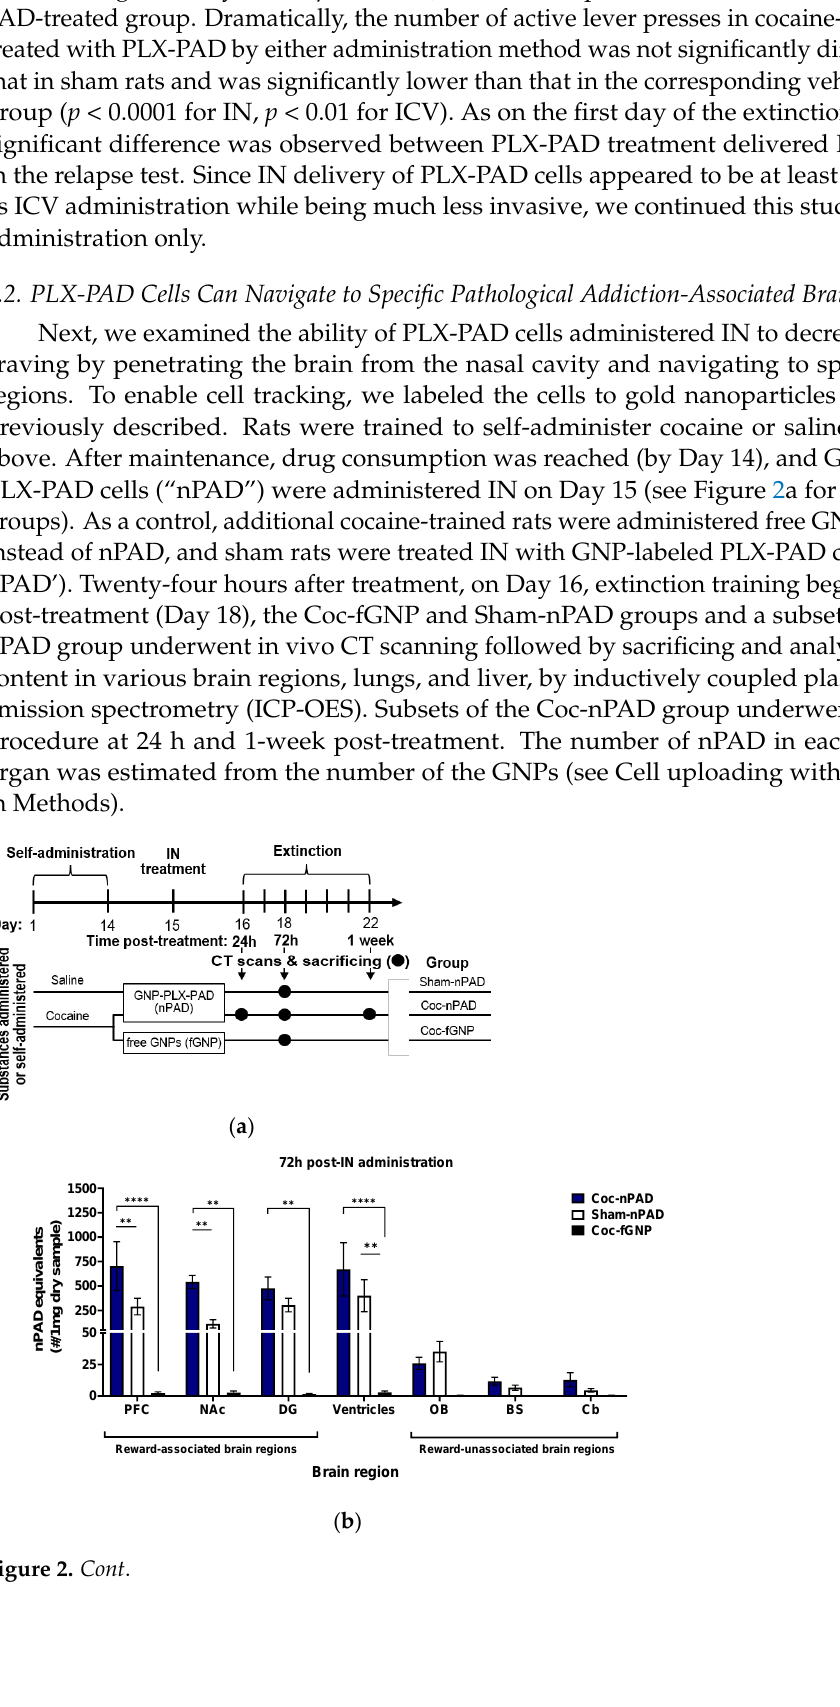
( c ) ( d ) Figure 2. PLX-PAD navigation in the brain. ( a ) Experimental design. Rats underwent self-admin- istration training with cocaine or saline on Days 1 – 14, then IN treatment on Day 15 with gold nano- particle (GNP)-labeled PLX-PAD (nPAD) or with free GNPs (fGNP), and extinction training on Days 16 – 22. At 24 h, 72 h, and/or 1 -week post-treatment (as indicated). Rats from each group underwent in vivo CT scanning followed by sacrificing and analysis of brain regions, lungs, and liver by induc- tively coupled plasma optical emission spectrometry (ICP-OES). nPAD equivalents were estimated from GNP number by nPAD (see GNP labeling section) and fGNP groups; ( b ) nPAD and fGNP accumulation in different brain regions 72 h post-treatment in relation to pathology. GNPs in each brain region were quantified using ICP-OES (n = 4 – 7 per group). Significance is shown only for within-region comparisons. Significance of nPAD number in the PFC, NAc, and DG Ventricle brain regions in Cocaine+nPAD vs. Sham+nPAD (however, except for the DG and Ventricle regions, discussed in the Results and Discussion) and Cocaine+nPAD vs. Cocaine+fGNP; ** p < 0.01, **** p < 0.0001, Tukey's multiple comparisons test. There was no significant main effect between groups in the Cb, BS, and OB brain regions; ( c ) nPAD accumulation in reward-associated and -unassociated brain regions and peripheral organs, over time in Coc-nPAD group. A comparison between Re- ward-associated brain regions (PFC, NAc, and DG), Reward-unassociated brain regions (Cb, BS, and OB), and Non-targeted organs (Liver and Lungs) n = 5 – 7 animals per group at each time point.